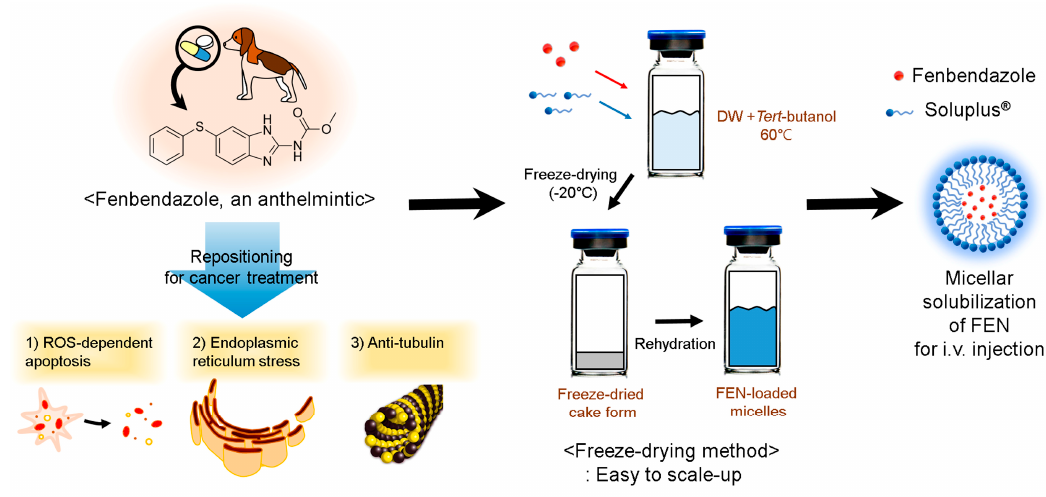
Figure 1. Schematic illustration of fenbendazole (FEN)-loaded Soluplus ® micelle preparation for i.v. injection.